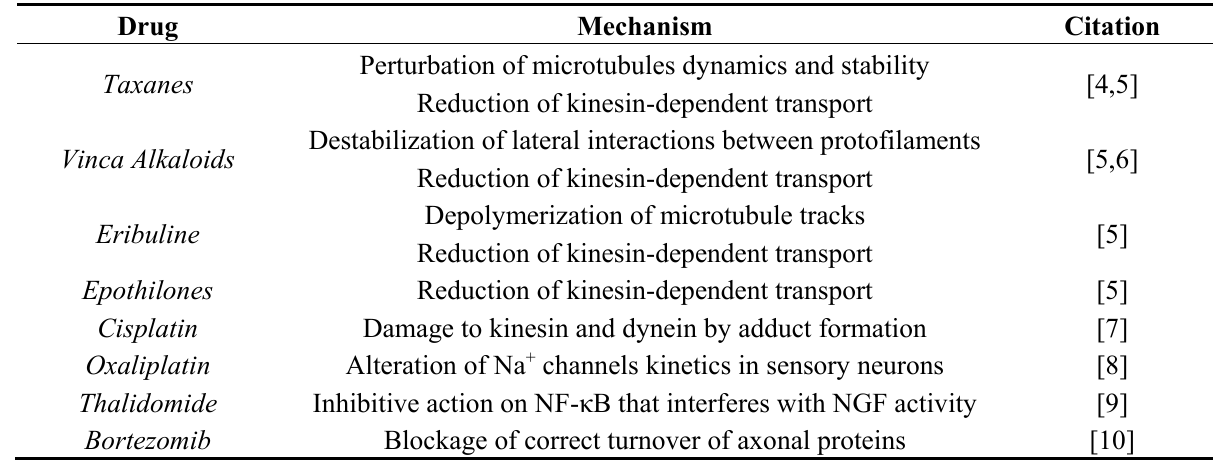
Table 1. Summary of drug mechanisms of axonal